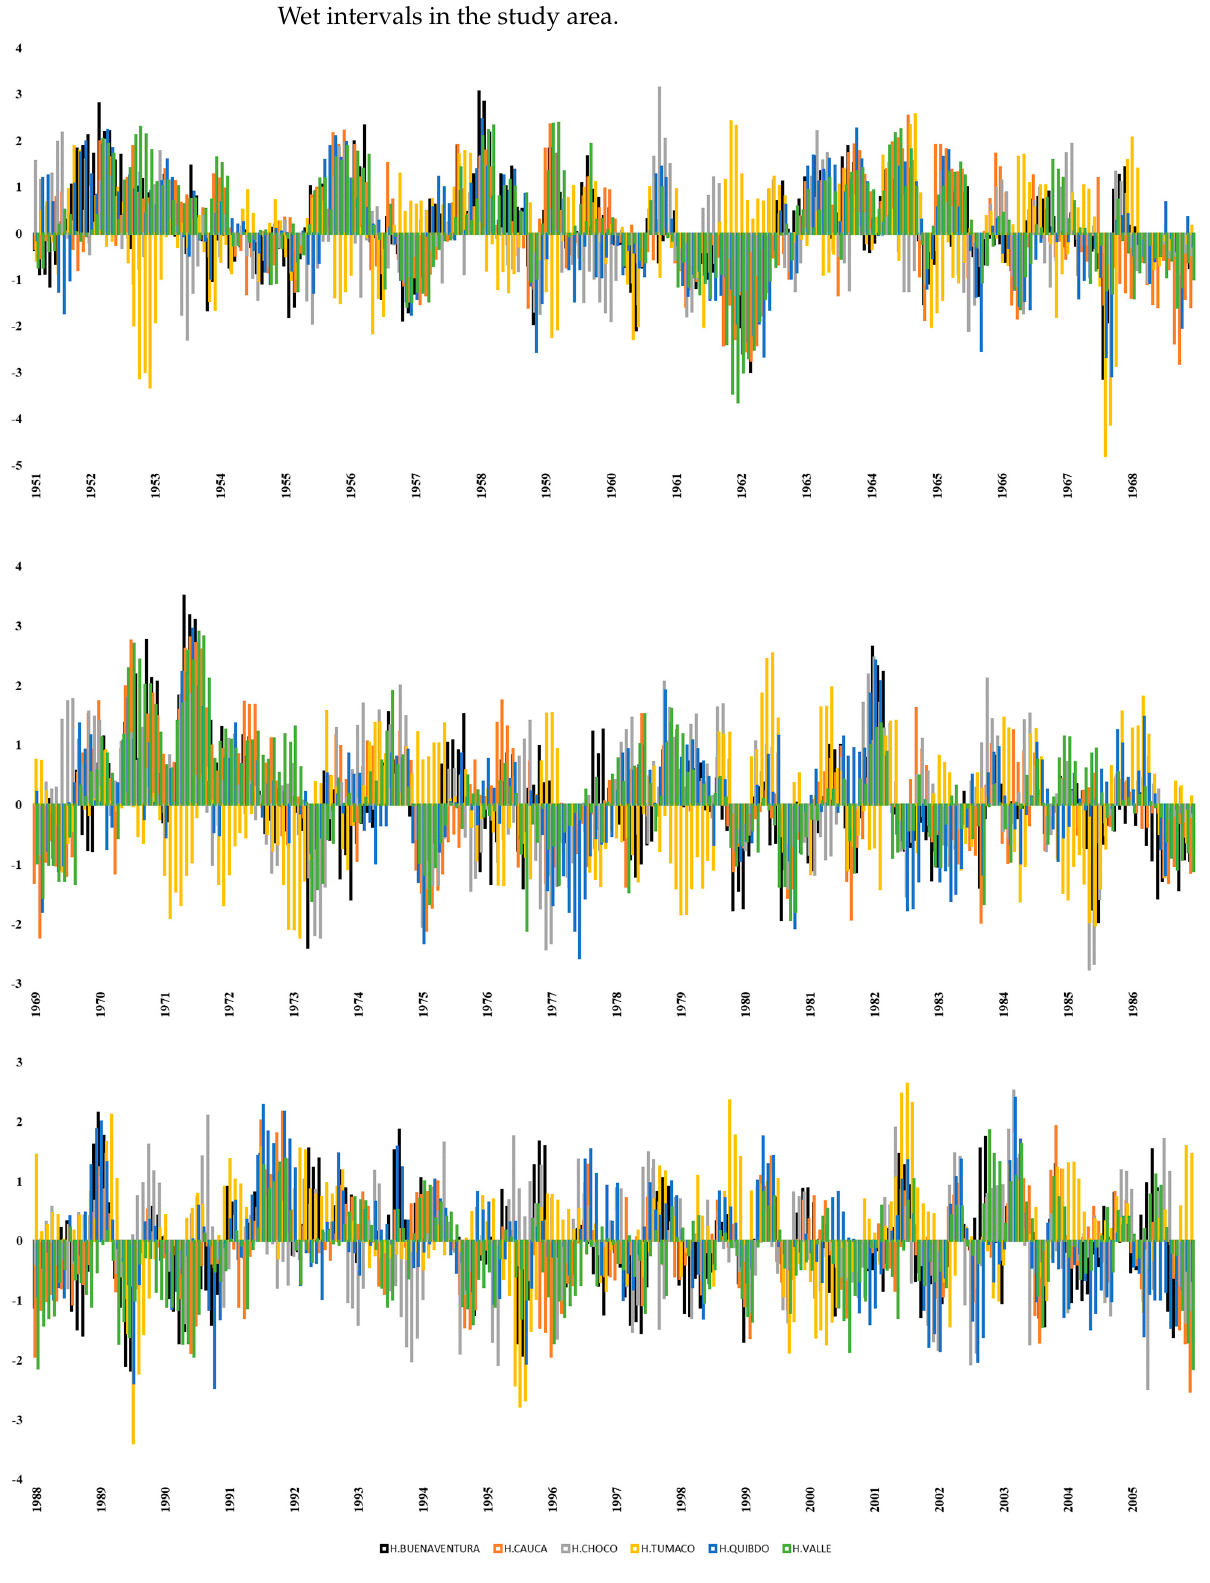
Figure 2. Three − month standardized precipitation index in Colombia’s Pacific region, 1951–2005.